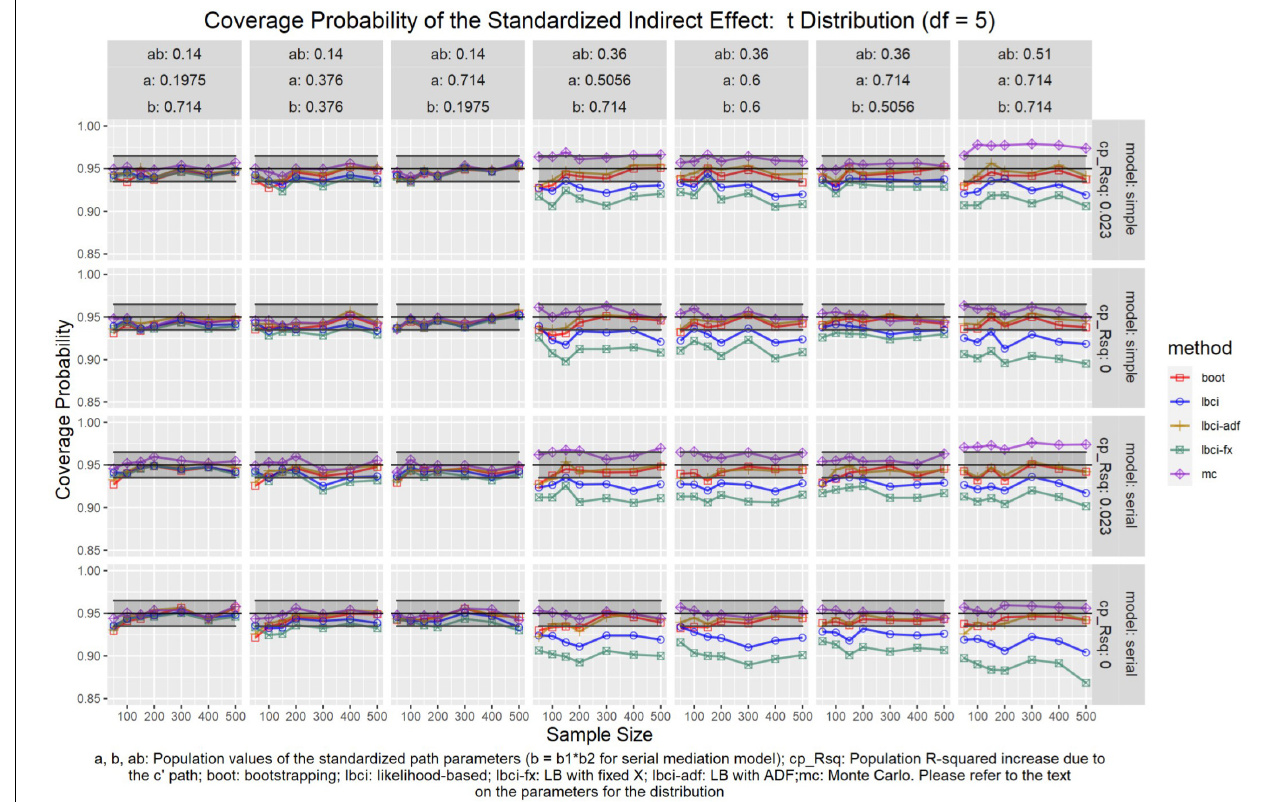
FIGURE 12 | t (5) Distribution (Standardized Indirect Effect). a, b, ab: Population values of the standardized path parameters (b = b1 × b2 for serial mediation model); cp_Rsq: Population R-squared increase due to the c (cid:48) path; boot: bootstrapping; Ibci: likelihood-based; Ibci-fx: LB with fixed X; Ibci-adf: LB with ADF;mc: Monte Carlo. Please refer to the text on the parameters for the